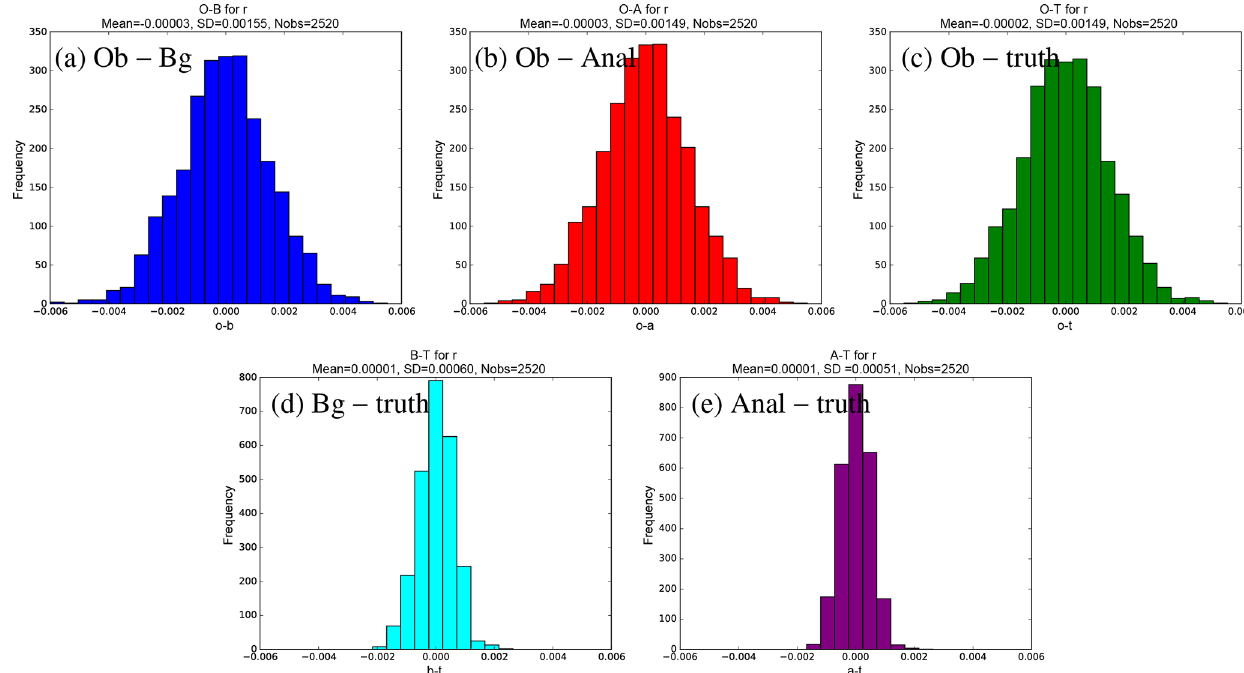
Figure 10. (a–c) Frequency histograms of y − H ( x ) for the seventh cycle of the GB + VR + experiment, where x is (a) x b , (b) x a , and (c) x t . (d, e) Histograms of H ( x ) − H ( x t ) , where x is (d) x b and (e) x a . Observations of